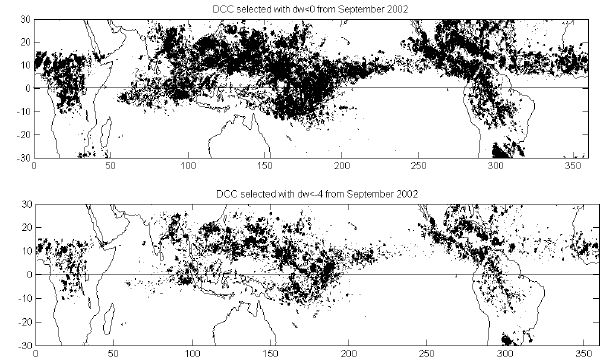
Figure 3. Top panel: CCF that satisfy the condition DTW < 0. Bottom: CCF that satisfy the condition 665 Fig. 3. Top: CCFs that satisfy the condition DTW<0. Bot- tom: CCFs that satisfy the condition DTW ≤ 667